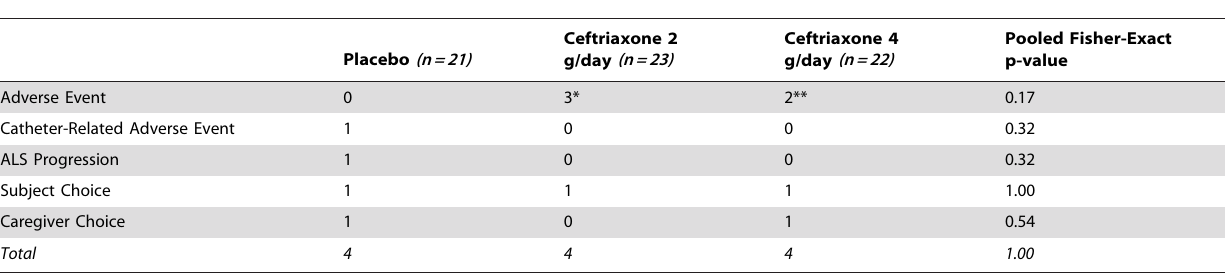
Table 2. Reasons for Drug Discontinuation in Stages 1 and 2.